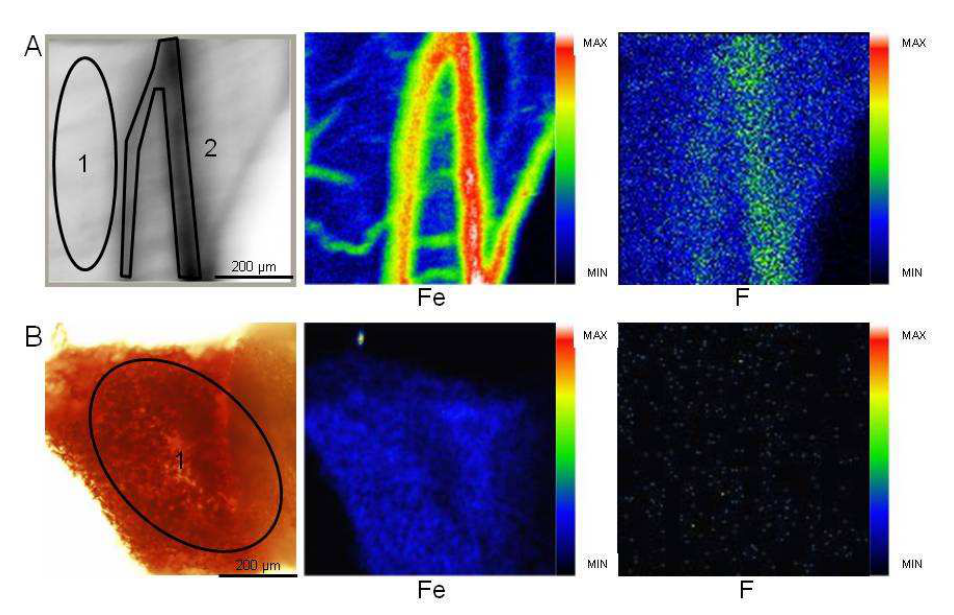
Figure 3. (A) Chemical elements distribution in CAM tissue exposed to the polyfluorinated glucose (sample 4). Average fluorine concentration: surrounding tissue (zone 1: 2240 ± 260 µg/g), capillaries (zone 2: 1290 ± 150 µg/g). ( B) Chemical elements distribution in tumor section S4 exposed to the polyfluorinated glucose (Table 2, sample 5). Average fluorine concentration in tumoral tissue (zone 1: 130 ± 20 µg/g). Min-max range bar units are